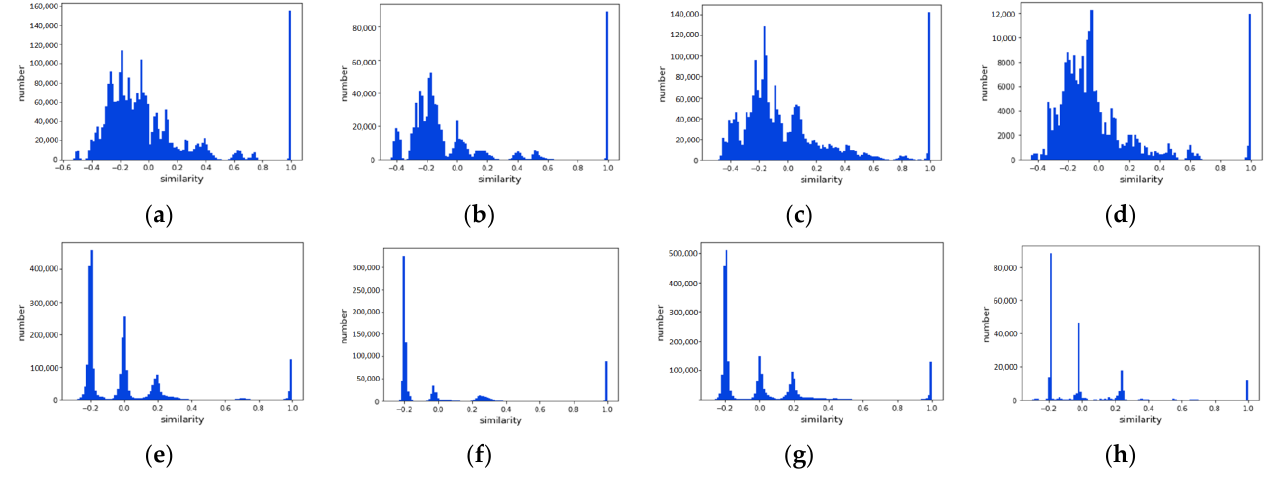
Figure 24. Distribution of similarity when 𝑇 = 1.0, ℎ = 25. ( a – d ) SCL over the Indian Pines dataset, the Pavia University dataset, the Houston dataset, and the Chikusei dataset; ( e – h ) SCL–MSR over the Indian Pines dataset, the Pavia University dataset, the Houston dataset, and the Chikusei dataset.